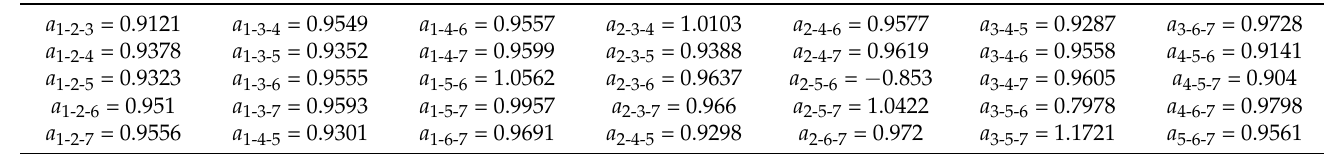
Table 7. The set of a r - s - t values of the probable theoretical elastic deformation at the compression and torsion loaded of a pole with arm in the console, determined based on k = 7 FEA analyses with different discretization levels (in mm).